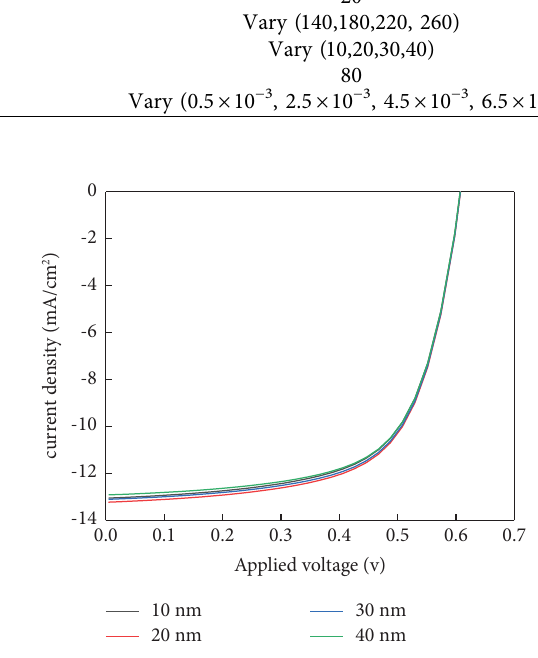
Figure 3: Current density vs applied voltage at diferent thickness of Table 3: Evaluated parameters of the cells for various thickness of HTL.